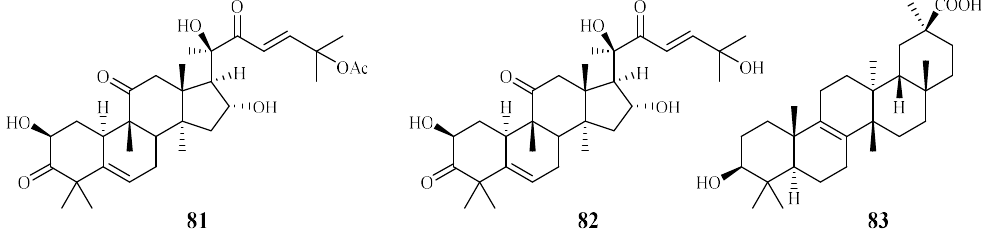
Figure 14. Compounds from a Cucurbitaceae plant.